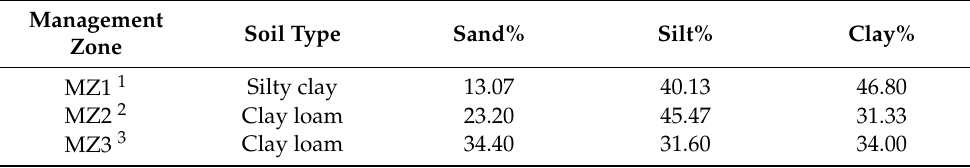
Figure 3. Polygons of the delineated management zones of the study area. Hollows in the image are wet parts of the field where the farmer does not plant. The strip is a 10 m buffer from the road that crosses the study area. Table 3. Soil proprieties of the study